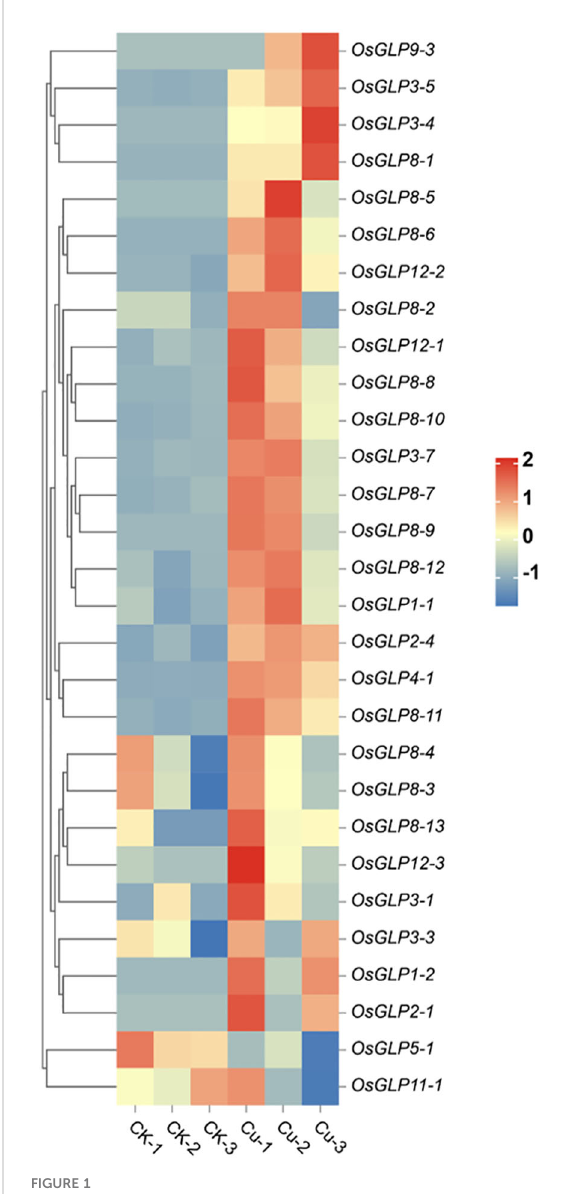
FIGURE 1 Cu toxicity induces the expression of OsGLP8 - 2 in rice. Transcription levels of OsGLPs increased under heavy metal treatment. Total RNA was isolated from the roots of 4-day-old WT (wild type) rice seedlings treated with 3 m mol L − 1 CuSO 4 for 12 h and used for transcriptome sequencing. Values are the mean ± SD; n = 3. Fold change ≥ 2 and FDR ≤